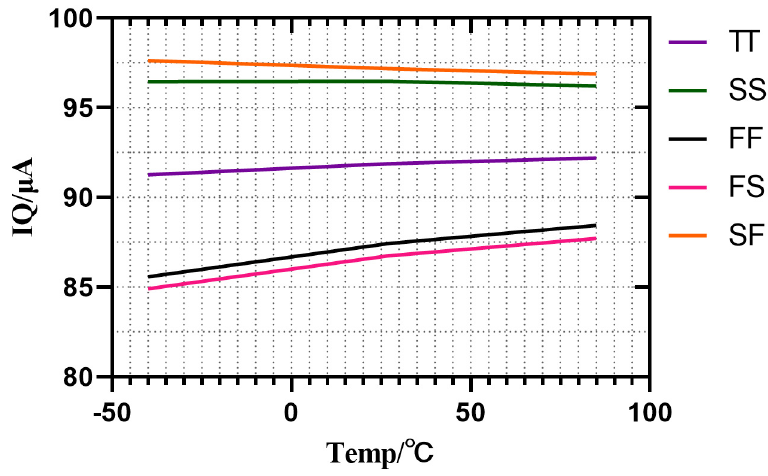
Figure 10. Quiescent current for different temperatures and process corners.